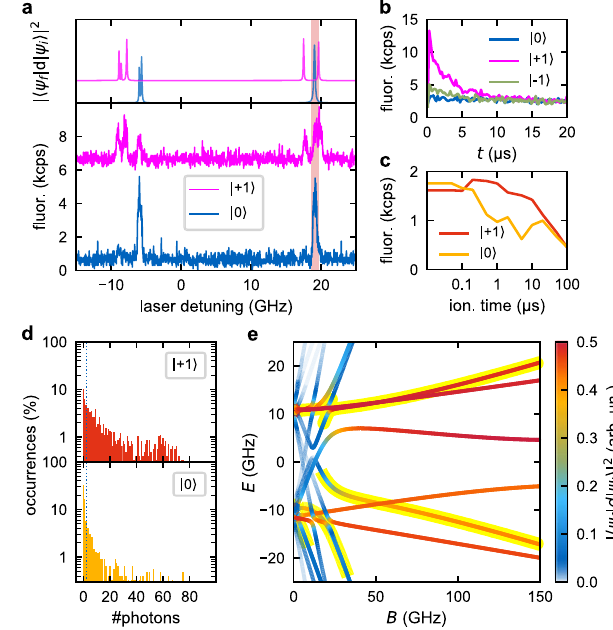
Fig. 3 Spin-dependent ionization. a Average fl uorescence of the charge- state readout after charge initialization (without postselection), spin initialization according to Fig. 1c, and spin-dependent ionization with varying time. For b and c , 2 μ s was used. b Distribution of the number of fl uorescence photons that were detected during 1 ms of readout, after preparing the NV − in either spin | + 1 〉 or |0 〉 and spin-dependently ionizing it for 2 μ s. The as-measured fi delity is (88.5 ± 0.5)%. The dotted line indicates the threshold used for analysis. Sketches of the used sequences are inset. c Rabi oscillation measured accordingly to panel b . The y -axis is the fraction of experimental repetitions with detected photon number during readout above threshold. The data were measured within about 11 s. The red line is a cosine fi t. d Sequence as used for panel b . The color-code is explained in Fig. 1. whole initialization – ionization – readout protocol (Fig. 3d) for both spin preparations. The measured end-to-end fi delity of the scheme is (88.5 ± 0.5)% (SNR 1.74 ± 0.06). Correcting for